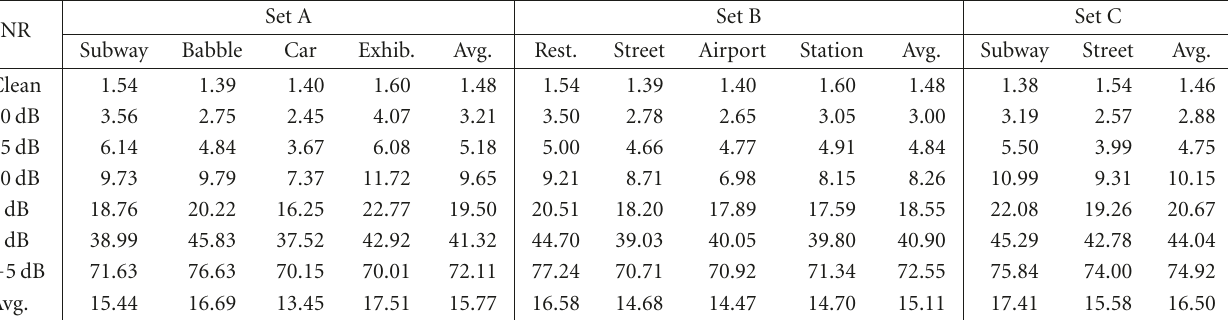
Table 5: Recognition results of the CHEQ compensation technique on the Aurora 2 task under clean-condition training (WER